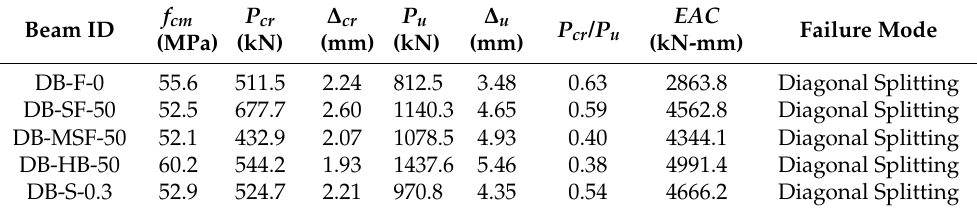
Table 5. Summary of test